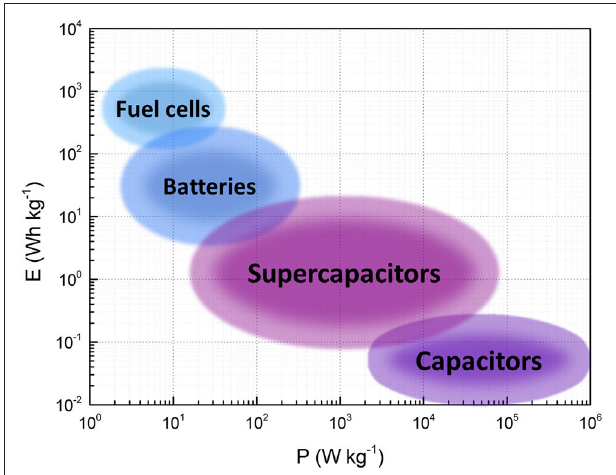
FIGURE 2 | Ragone plot showing the typical values of energy and power of different energy storage devices ( Inamuddin et al.,